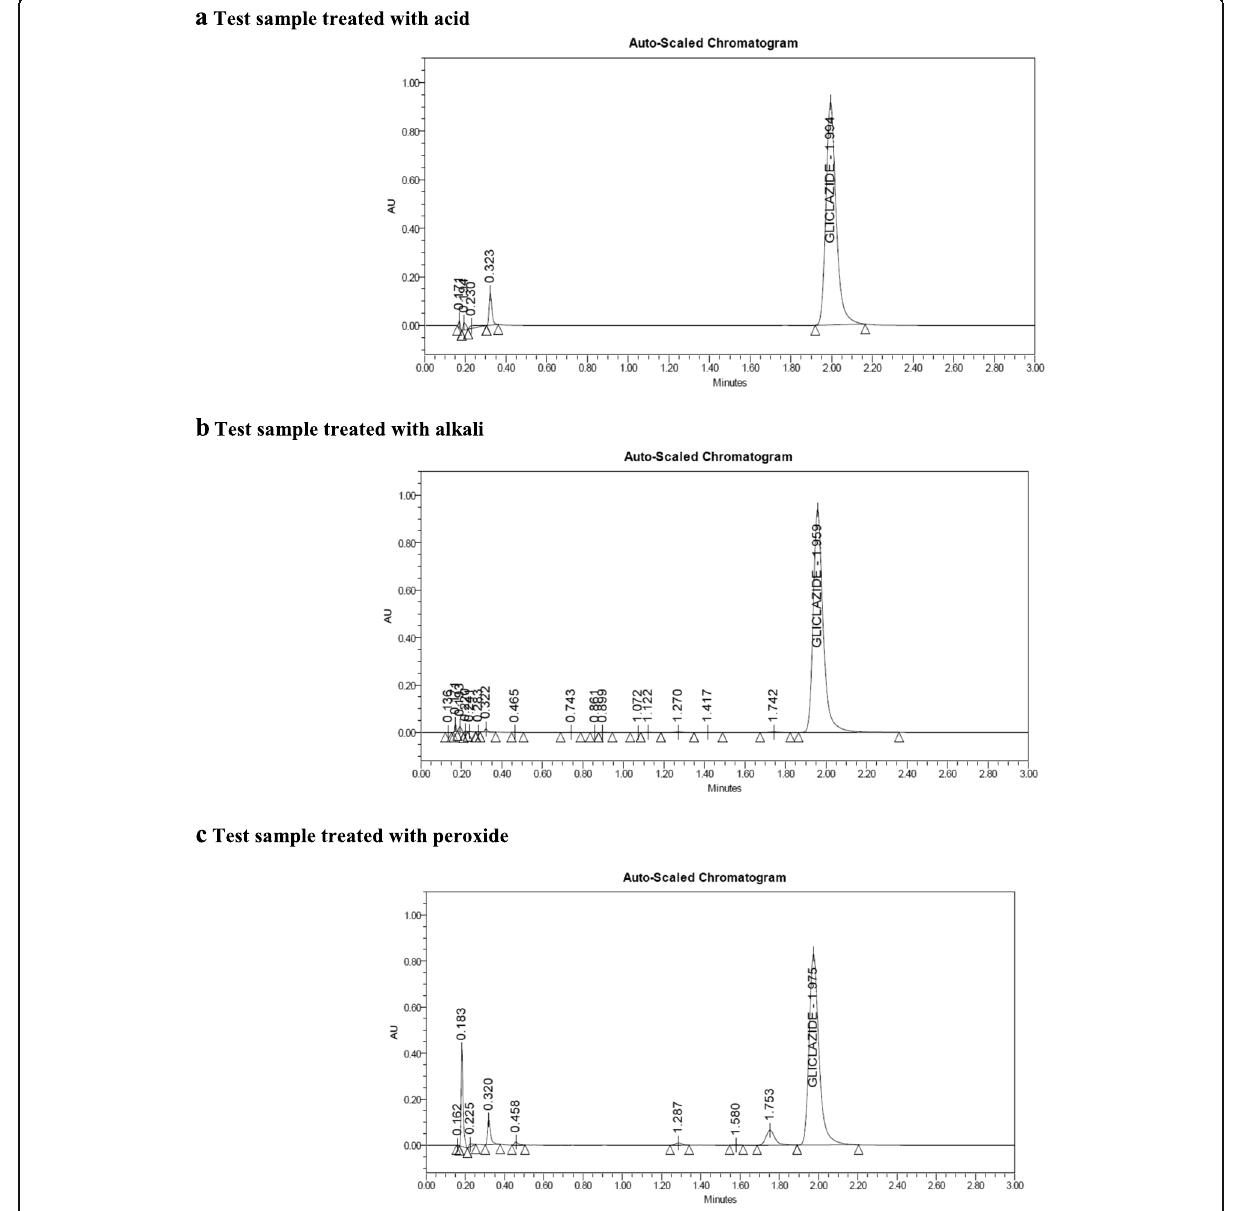
Fig. 2 UPLC chromatograms of forced degradation study. a Test sample treated with acid, b test sample treated with base, and c test sample treated with